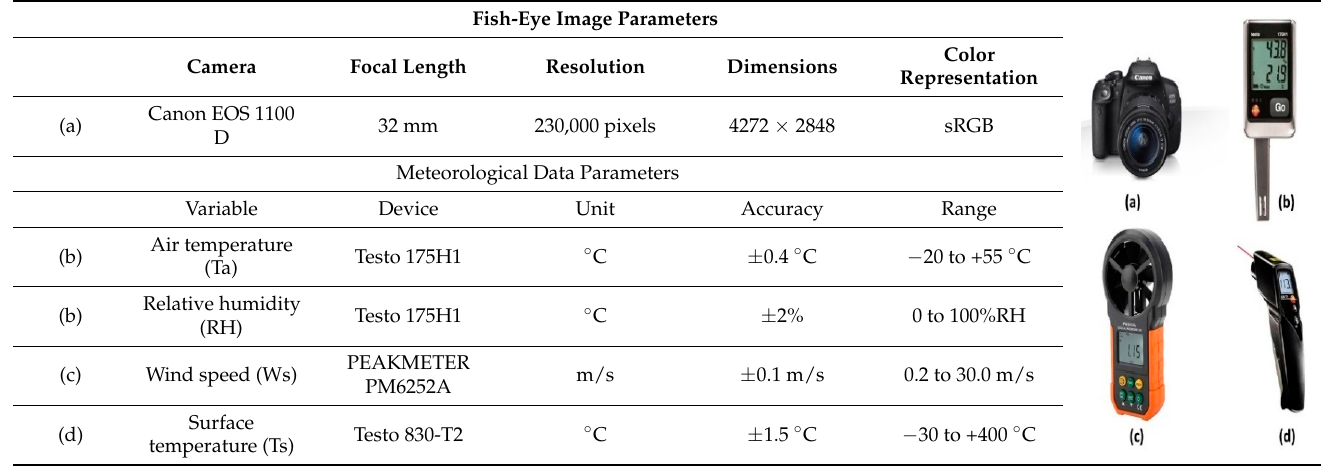
Table 2. Instruments used for the study: ( a ) fish-eye camera; ( b ) Testo 175H1 temperature/humidity data logger; ( c ) PEAKMETER Anemometer; ( d ) Testo 830 Infrared Thermometer.